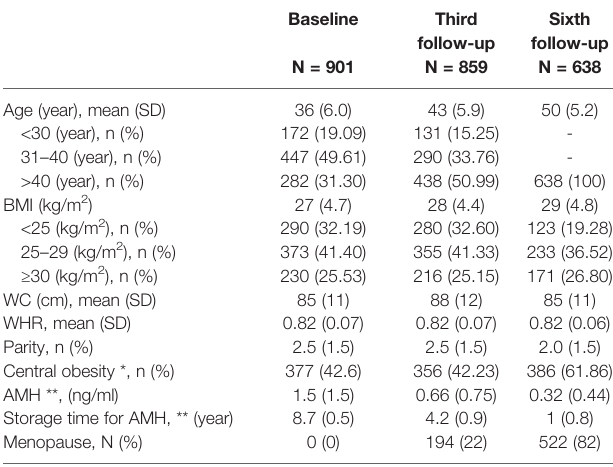
TABLE 1 | Characteristics of study participants.